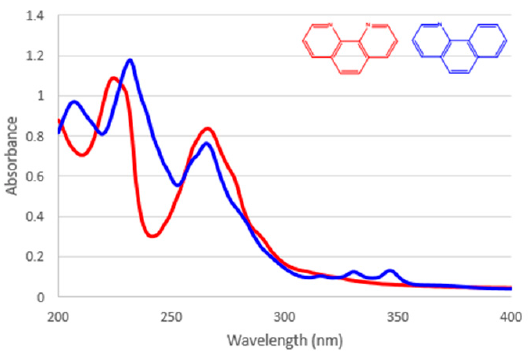
Figure 4. UV spectra of PHEN (red) and Bequ (blue) at the same concentration in ethanol and water solution.